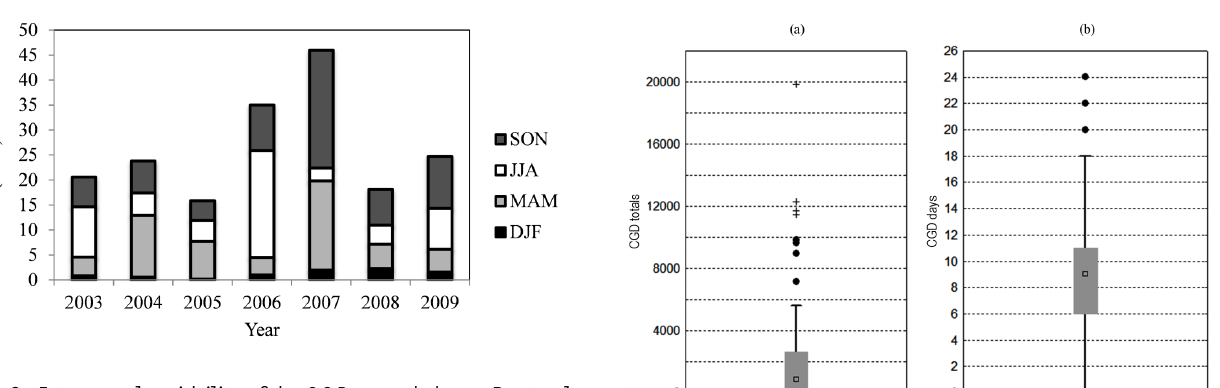
Fig. 2. Interannual variability of the CGD recorded over Portugal Figure 2. Inter-annual variability of the AEDCGD recorded over Portugal in the time 650 in the time period from 2003 to 2009. period from 2003 to 2009. 651